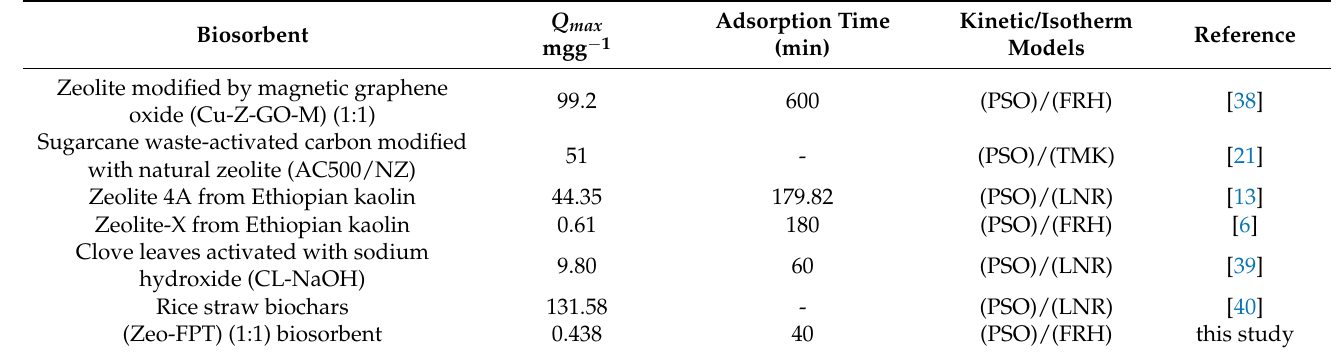
Table 5. A comparison between the sorption characteristics of the established Zeo-FPT (1:1) biosorbent and some other biosorbents used for MB dye removal.